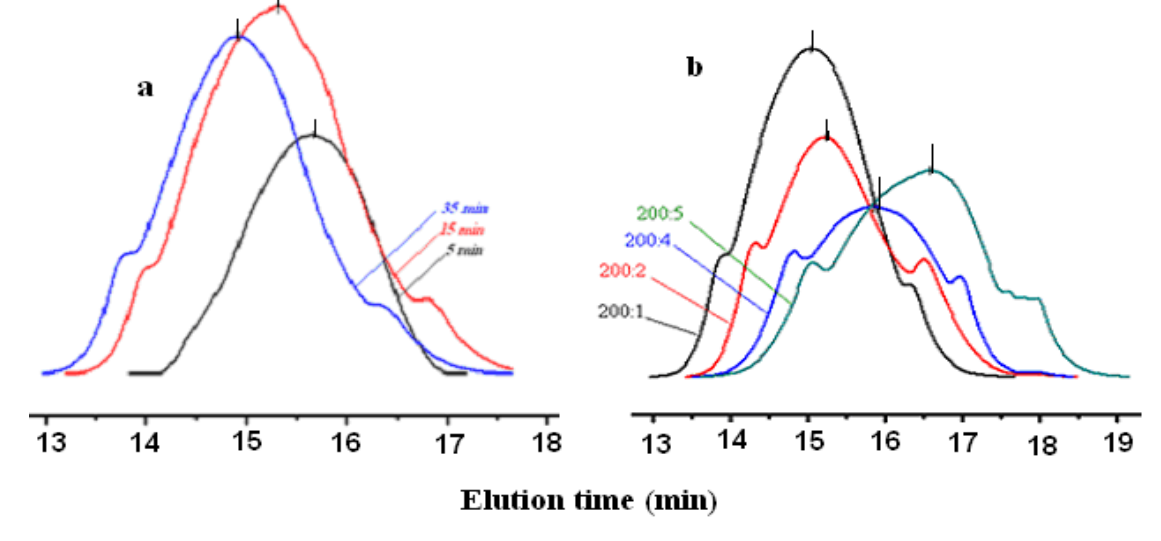
Figure 6. Molecular weight distributions for PVK star with: ( a ) polymerization time (Table 1, entry 1, 3 and 7), and ( b ) using different monomer-to-chain transfer ratios; polymerization time = 25 min. (Table 1, entry 5, 8, 9 and